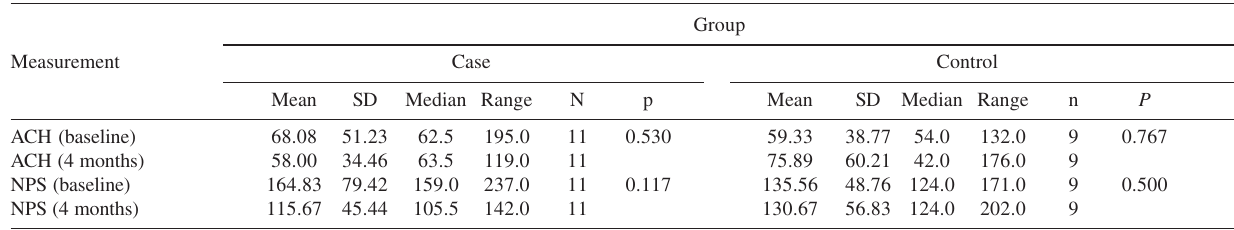
Table 2 - Maximum venous dilation (Emax) with acetylcholine (ACH) and with nitroprusside (NPS) at baseline and after four months, in the study and control groups